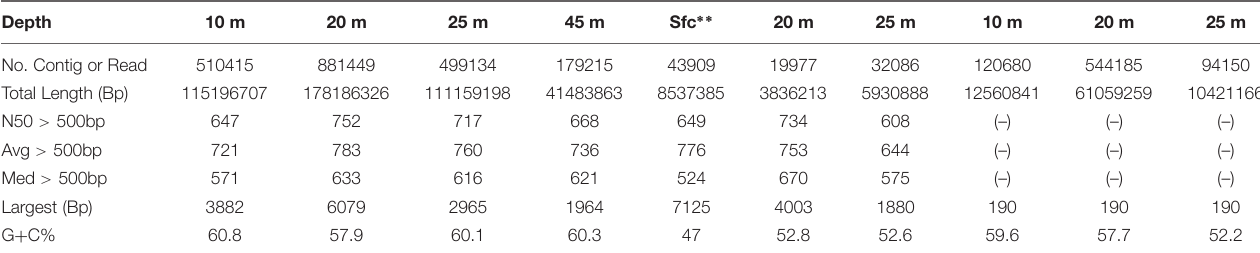
TABLE 1 | Pavilion Lake metagenome assembly statistics using Ray Meta DeNovo Assembler.